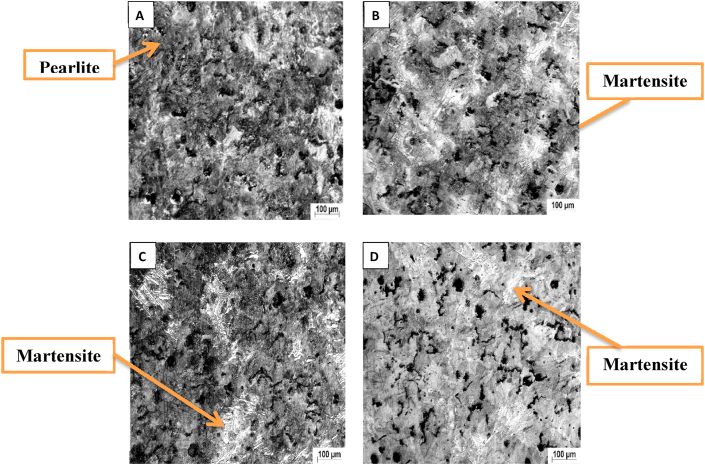
Pearlite % for sample number 2 with different thicknesses: A) Wall thickness 5mm, pearlite % 85.36 and B) Wall thickness 10mm, pearlite % 84.50, C) Wall thickness 15mm, pearlite % 88.89, and D) Wall thickness 20mm, pearlite % 90.11.